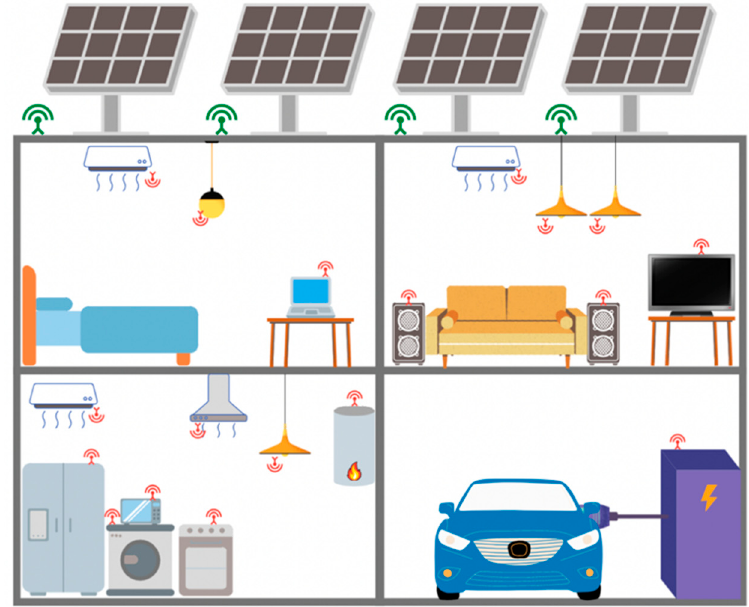
Figure 4. Renewable energy community concept.